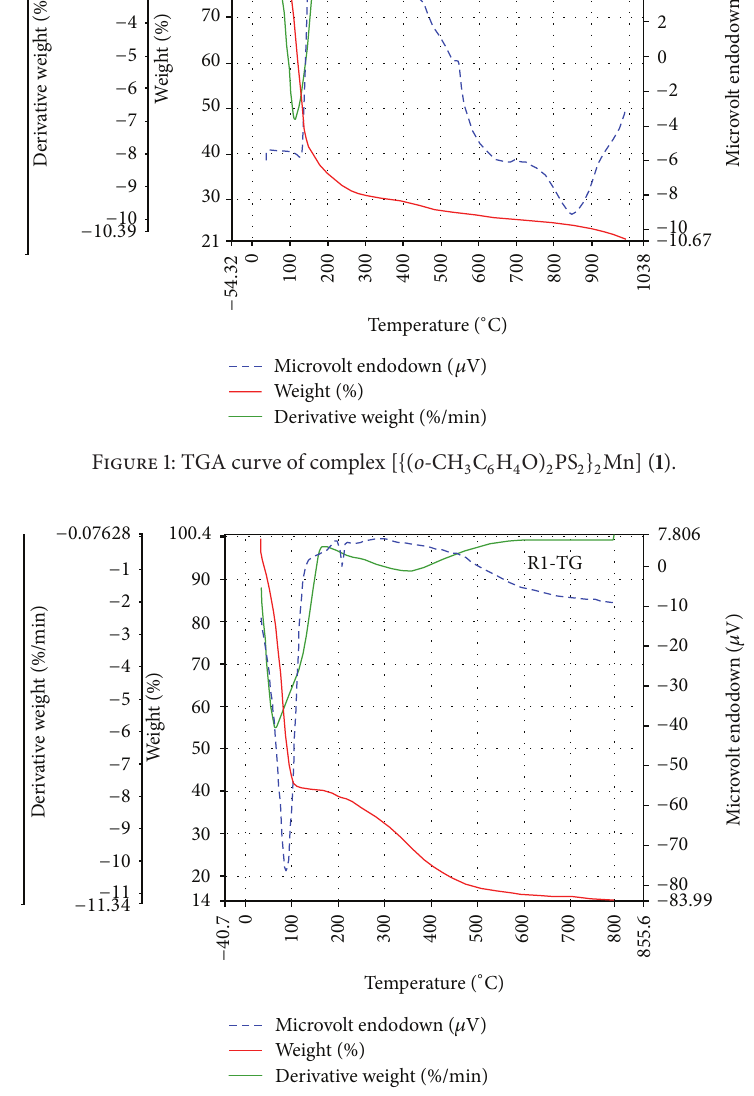
Figure 2: TGA curve of [ { ( o- CH 3 C 6 H 4 O) 2 PS 2 } 2 Mn ⋅ N 2 C 12 H 8 ] ( 5